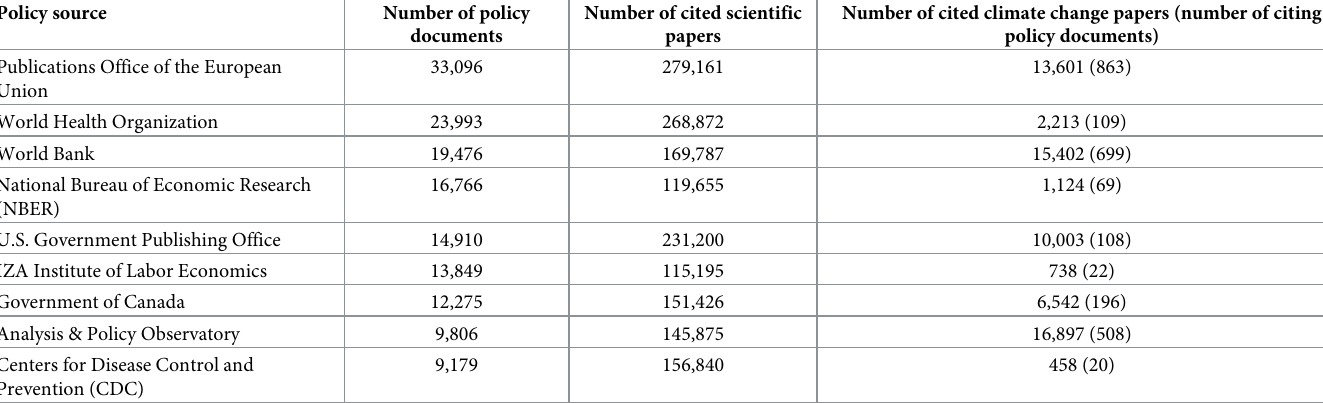
Table 1. Policy sources with the highest number of policy documents (sorted by the number of policy documents). The table also reveals the number of scientific papers cited by these institutions and the number of climate change papers (the number in brackets is the number of policy documents citing the climate change papers).